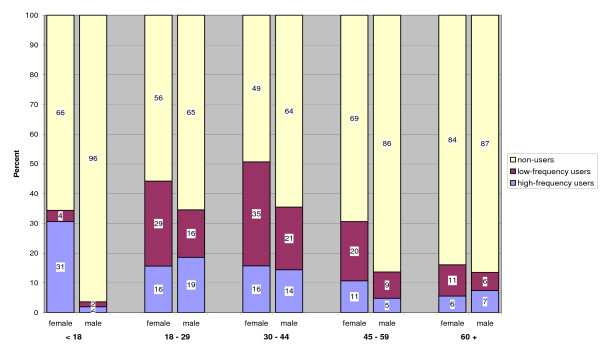
Comparison of tanning bed use by age & gender.